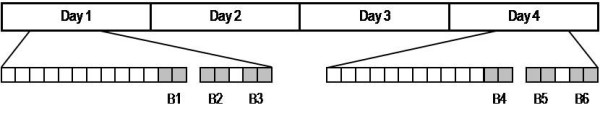
Experimental design. Practice sessions are scheduled at Day 1 and Day 4. Squares: blocks of practice session; grey squares: blocks of interest for the statistical analyses (performance is computed over 2 successive blocks). Day 1. B1: end of session 1 (blocks 12–13); B2: starting session 2 (blocks 14–15); B3: end of session 2 (blocks 17–18); Day 4. B4: end of session 3 (blocks 30–31); B5: starting session 4 (blocks 32–33); B6: end of session 4 (blocks 35–36).